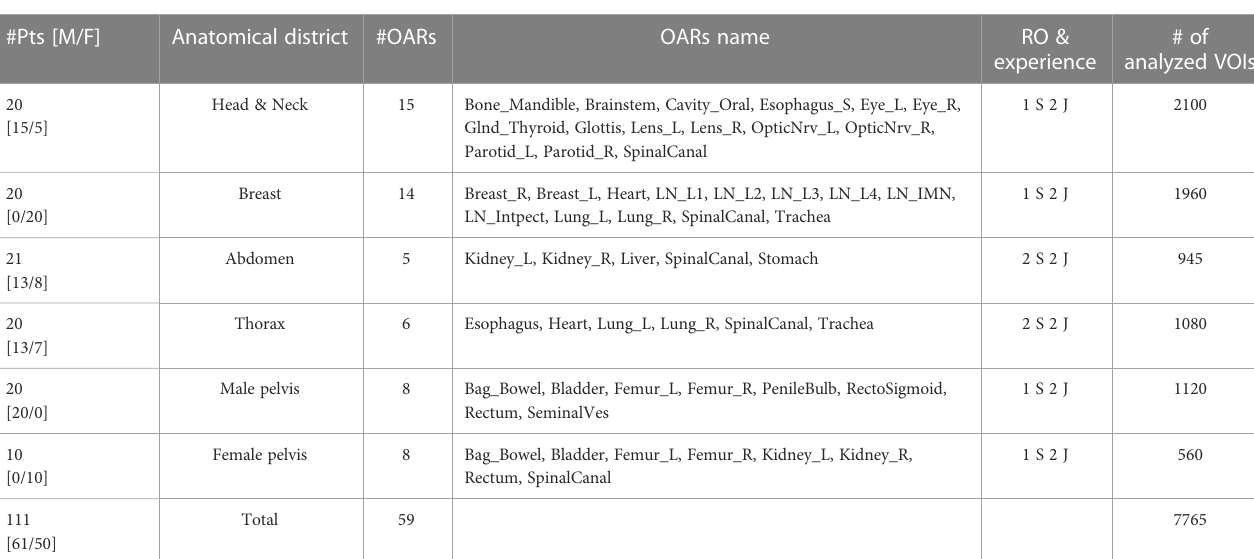
TABLE 1 Number of patients and delineated OARs for each investigated anatomical